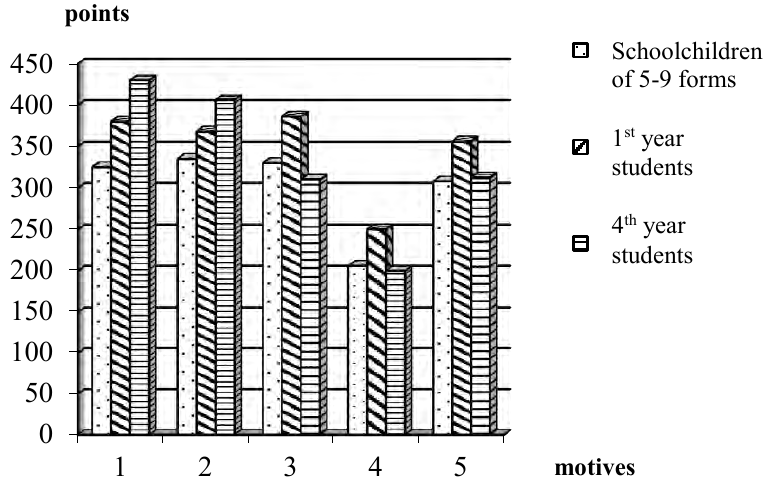
Fig.2. Results of schoolchildren’s and 1 st and 4 th year students’ questioning of social motives for practicing of health related tourism: 1 –pleasant spending of leisure; 2 –diversification of leisure; 3 –obtaining of new useful knowledge and skills; 4 –accompanying of friends or by advice of parents or teachers; 5 – participation in hiking, excursions and field trainings.